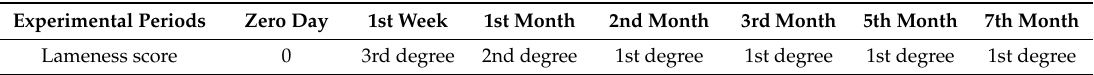
Table 1. Lameness score according to American Association of Equine Practitioners (AAEP). Experimental Periods